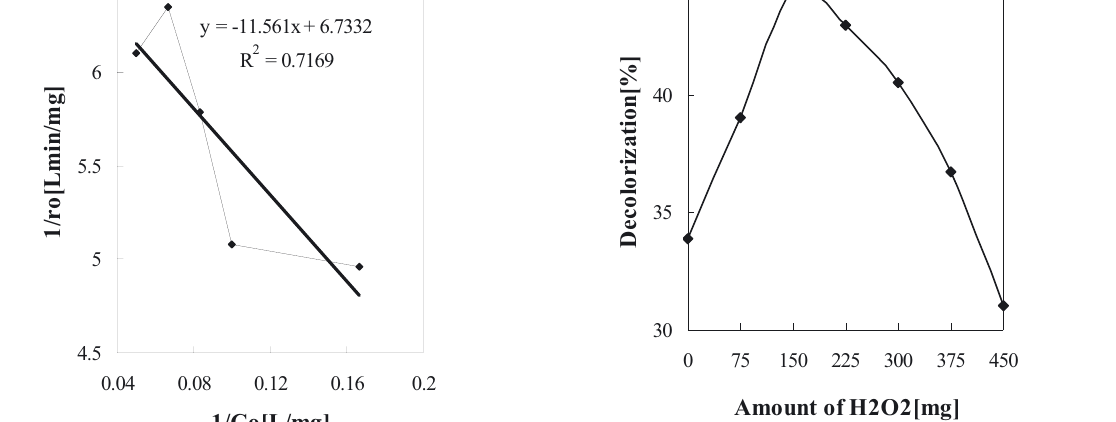
Figure 7. Effect of H